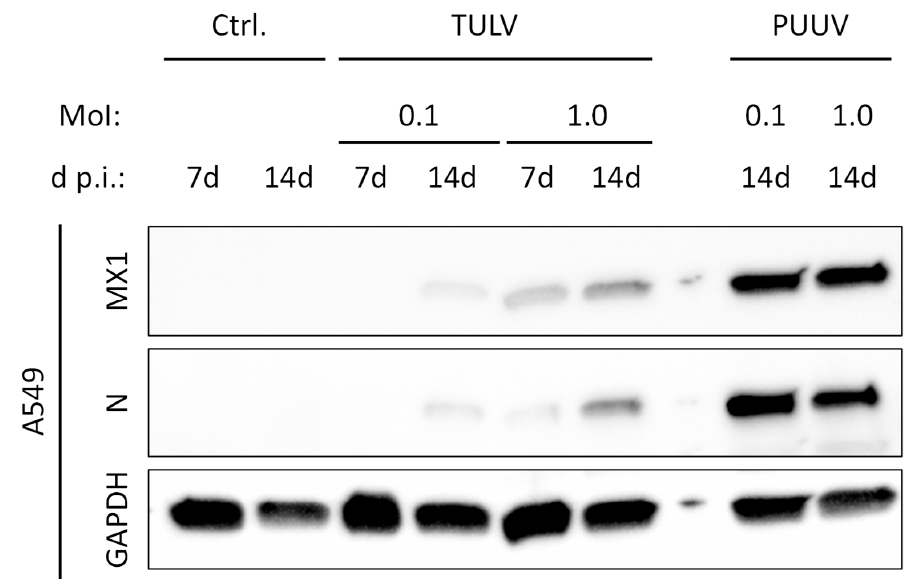
Figure 6. IFN-stimulated MX1 expression in PUUV- and TULV-infected cells. The expression of the cellular IFN-stimulated protein MX1 was analyzed in lysates of PUUV- or TULV-infected A549 cells. Expression of the viral nucleocapsid (N) protein was detected to monitor infection and cellular GAPDH served as loading control. Cells were infected with a MoI of 0.1 or 1.0 and protein expression was detected at 7 d or 14 d post infection.